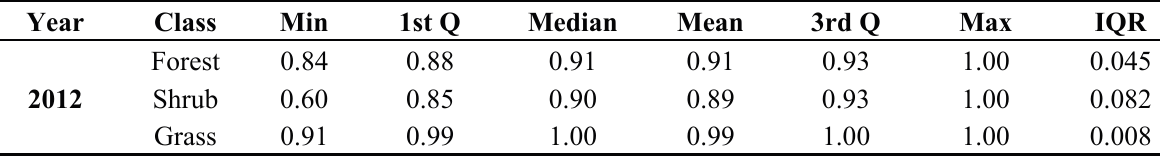
Table 6. Quartiles for geographically weighted logistic regression representing the probability of the classification correctly predicting the 2012 reference data. Interquartile range (IQR) represents the variability in probability among pixels. 1st and 3rd quartiles (1st Q, 3rd Q) represent the 25th and 75th percentile